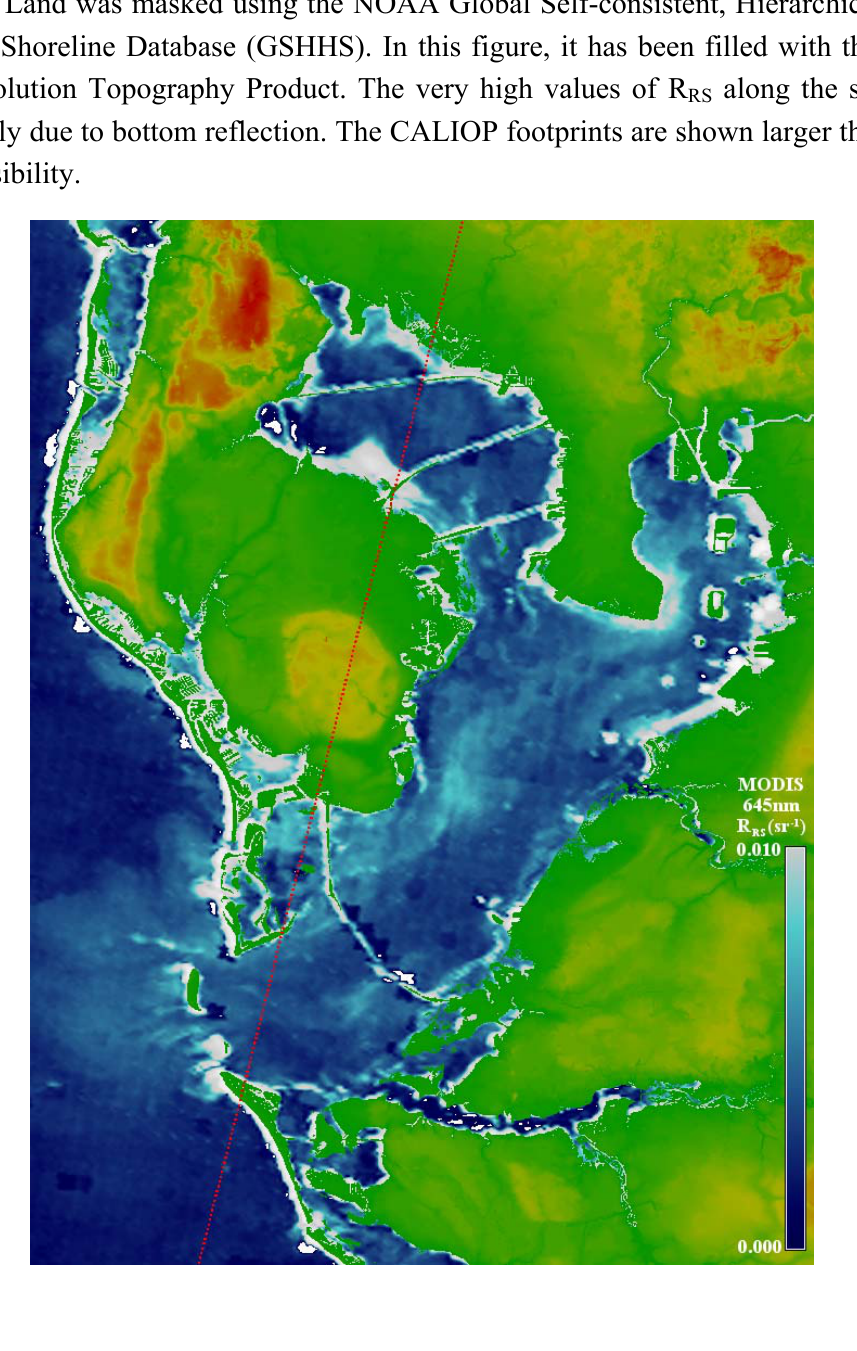
) (shades of RS along the shorelines RS